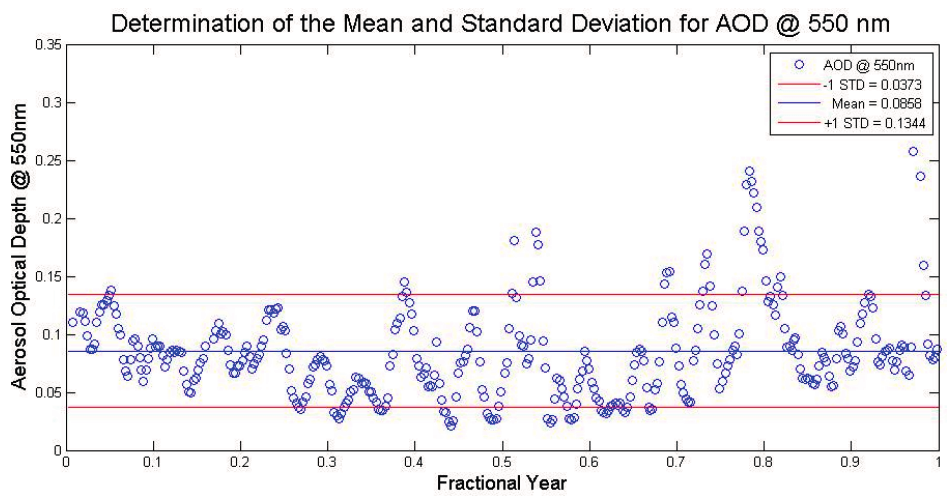
Figure 11. Aerosol levels over the Libya 4 test site.